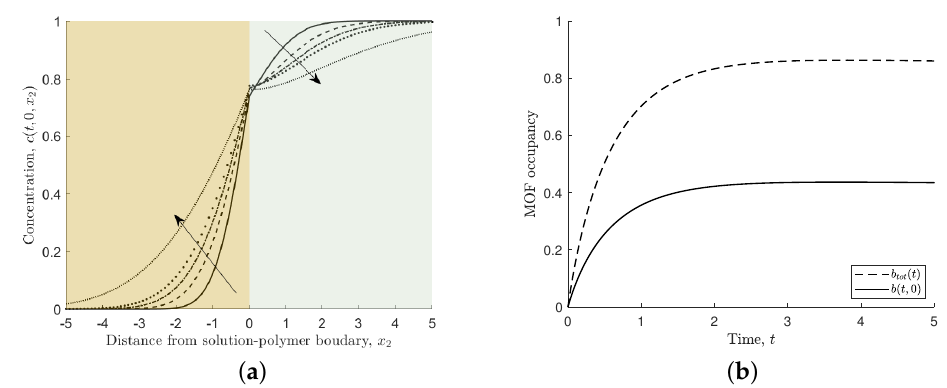
Figure 10. ( a ) Non-dimensional concentration of ferric ions through MOF-mid point across two media, c ( t ,0, x 2 ) . Arrow indicates the direction of increasing time, t = 0.5,1,1.5,2,5. ( b ) Non- dimensional MOF occupancy, b ( t ,0 ) and b tot ( t ) . Here, s 1 = s 2 = s 3 = s 4 = 1, and D =